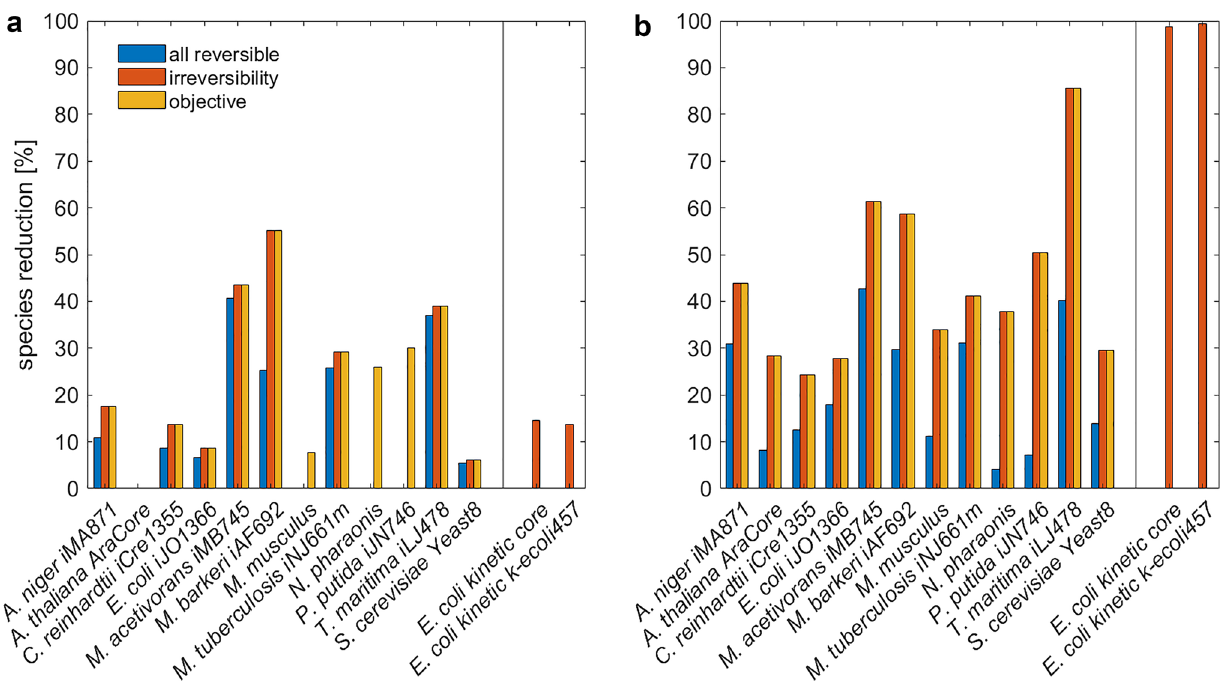
Figure 3. Reduction of genome-scale metabolic networks. Genome-scale metabolic models of twelve organisms from all kingdoms of life are used in the reduction ( a ) with arbitrary kinetics and ( b ) assuming mass action kinetics. The analysis also includes two large, mass-action kinetic models of E. coli. Shown is the percentage of reduction in the number of species with respect to the original